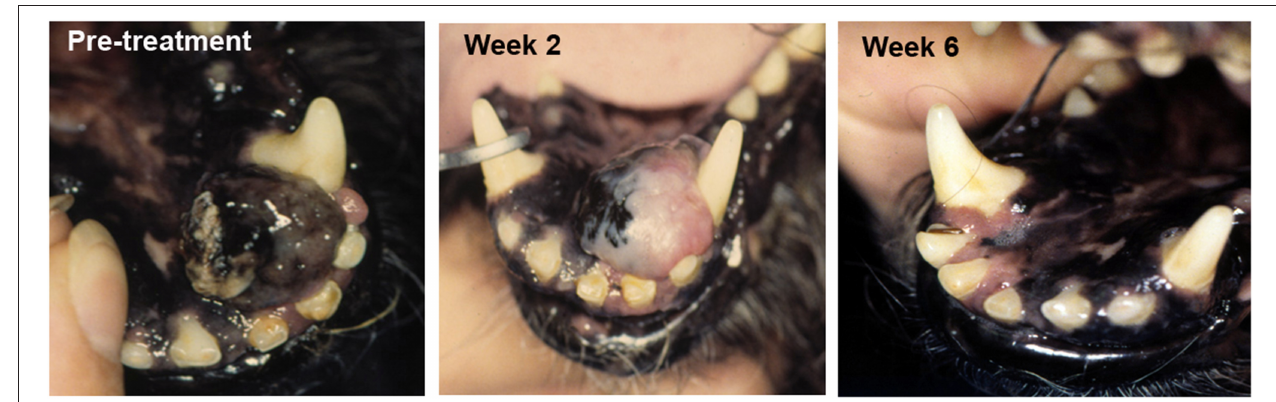
FIGURE 1 | Tumor response to TME modification with a T cell activator. A dog with oral malignant melanoma (left panel) was treated with a series of every 2 week intratumoral injections of plasmid DNA encoding a bacterial superantigen gene (SEB), along with an IL-2 encoding plasmid. Tumor depigmentation was evident after the first injection (middle image) and complete tumor regression was noted after the second intratumoral injection (right panel).